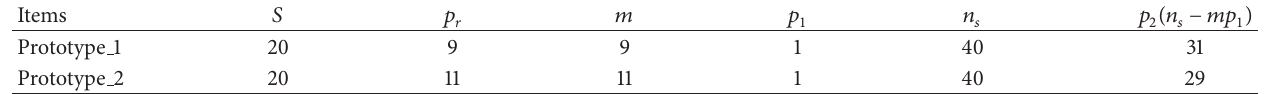
Table 2: Basic parameters of two prototypes.